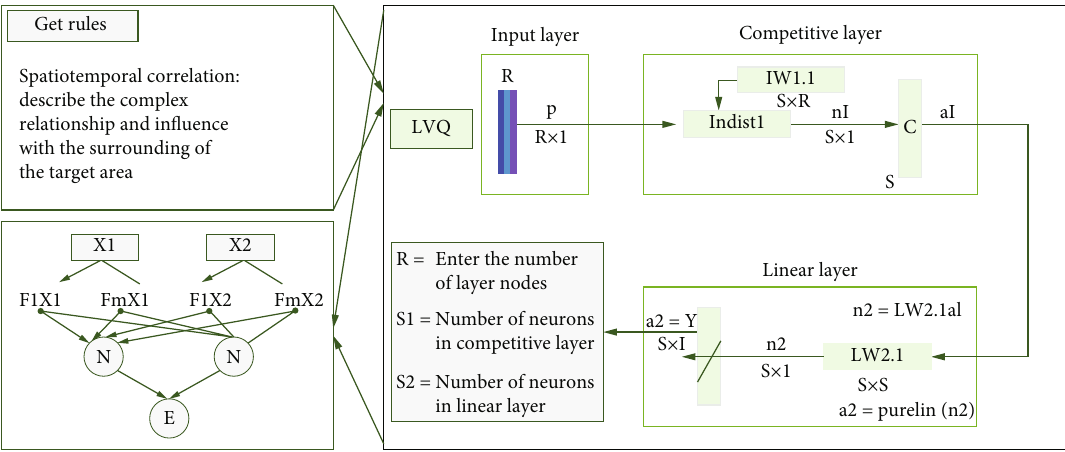
Figure 4: Internal structure and basic structure of the